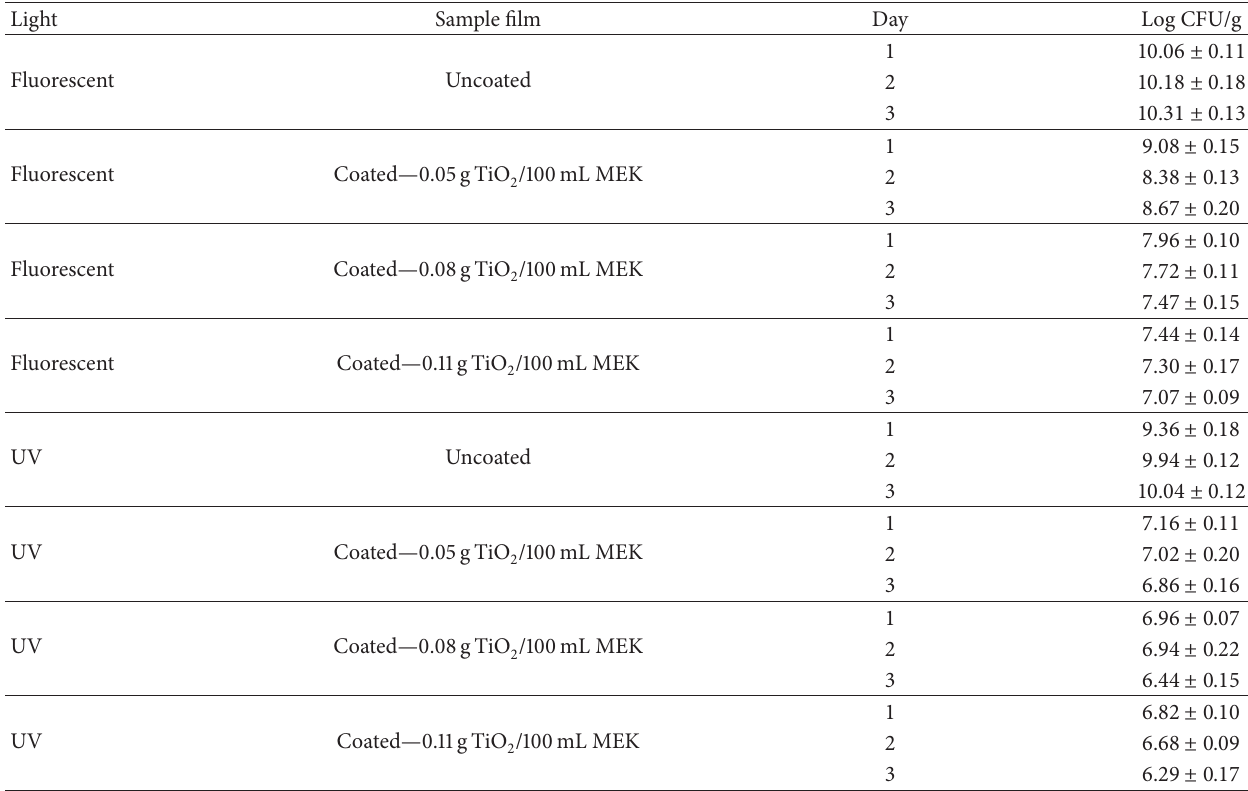
Table 1: The E. coli colony values (CFU/g) of the uncoated and coated films for various TiO MEK) at designated interval times (1, 2, 3 days) exposed under fluorescent and UV light.